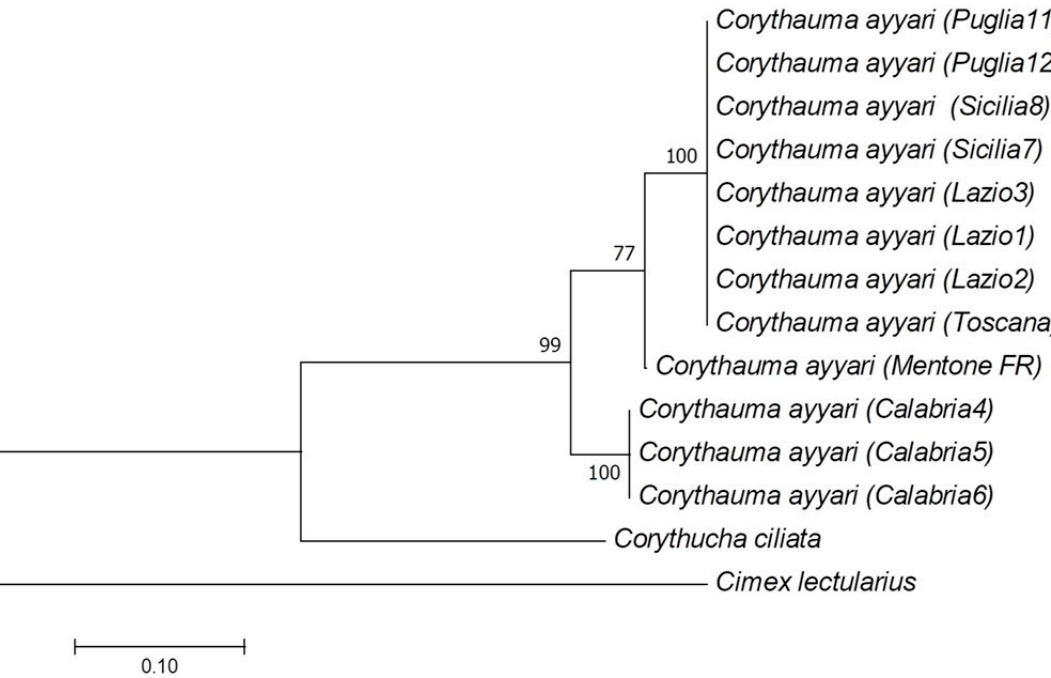
Figure 2. Phylogenetic tree derived from the pairwise alignment of COX and CytB sequences amplified from selected specimens and from two NCBI retrieved samples. The percentage of trees in which the associated taxa clustered together is shown next to the branches. The tree is drawn to scale, with branch lengths measured in the number of substitutions per site.